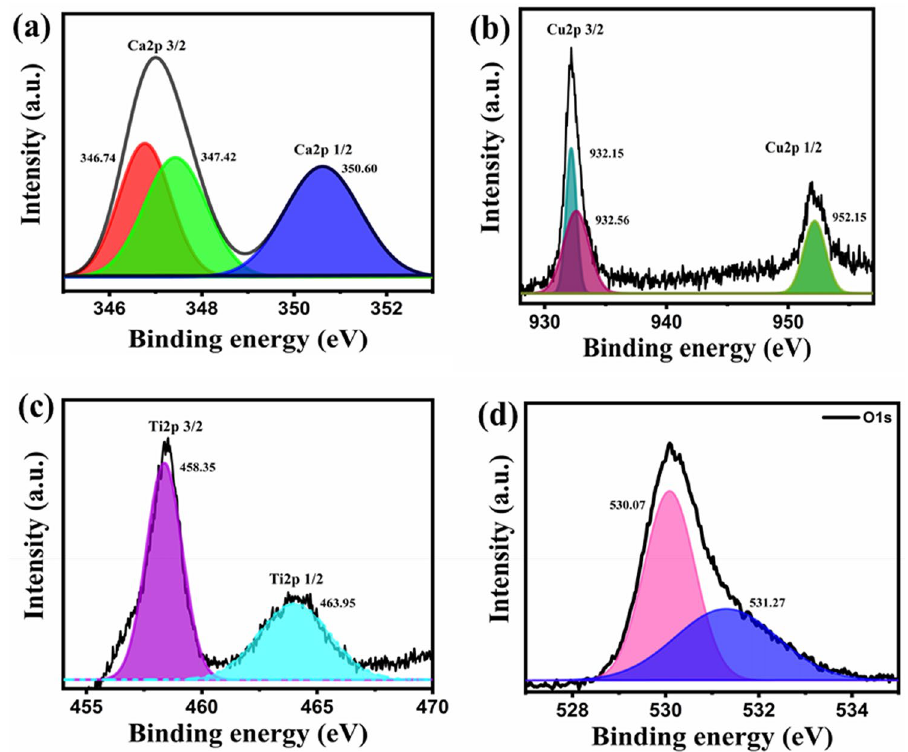
Figure 2. ( a – d ) XPS analysis of the CCTO